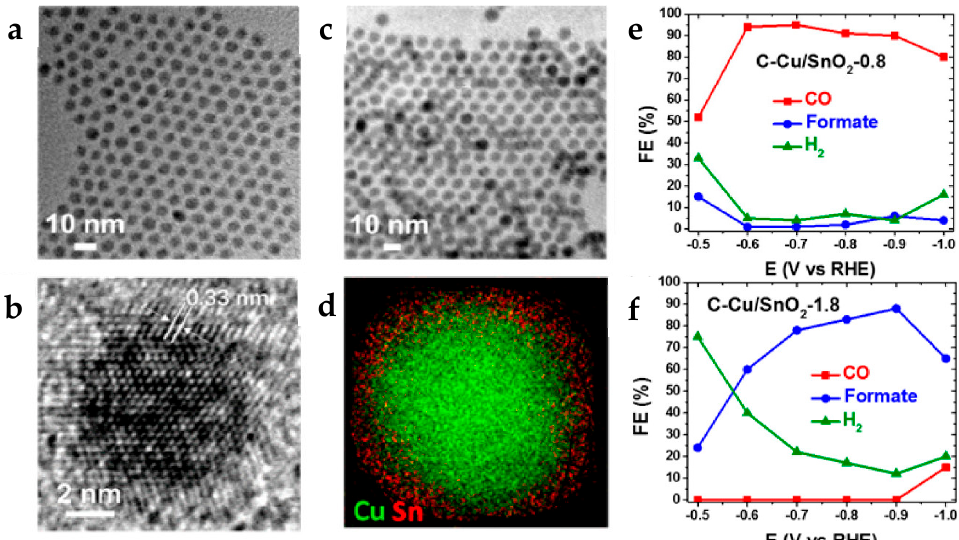
Figure 9. TEM images of ( a ) 7 nm Cu NPs and ( b ) Cu/SnO 2 (0.8 nm shell thickness) NPs. ( c ) HR-TEM image of a representative Cu/SnO 2 (0.8 nm shell thickness) NP. ( d ) EELS elemental mapping of Cu and Sn in a 0.8 nm Cu/SnO 2 NP. Reduction potential-dependent FE’s for electrochemical reduction of CO 2 measured on ( e ) C-Cu/SnO 2- 0.8 and ( f ) C-Cu/SnO 2- 1.8 catalysts. Reprinted (adapted) with permission from [70]. Copyright 2017 American Chemical Society.